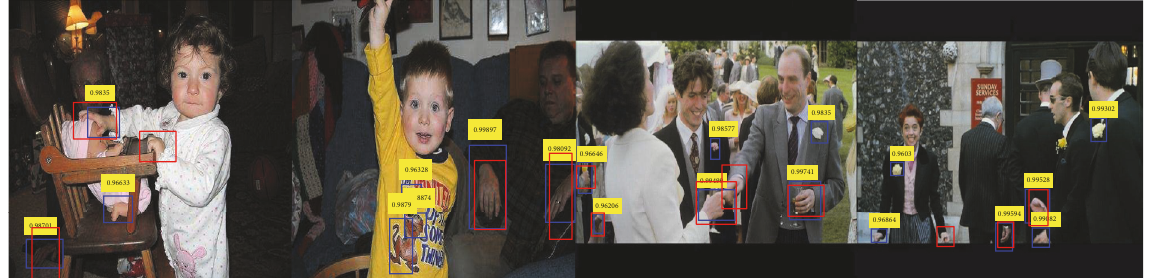
Figure 9: Incorrectly detected examples from the Oxford Hand Detection